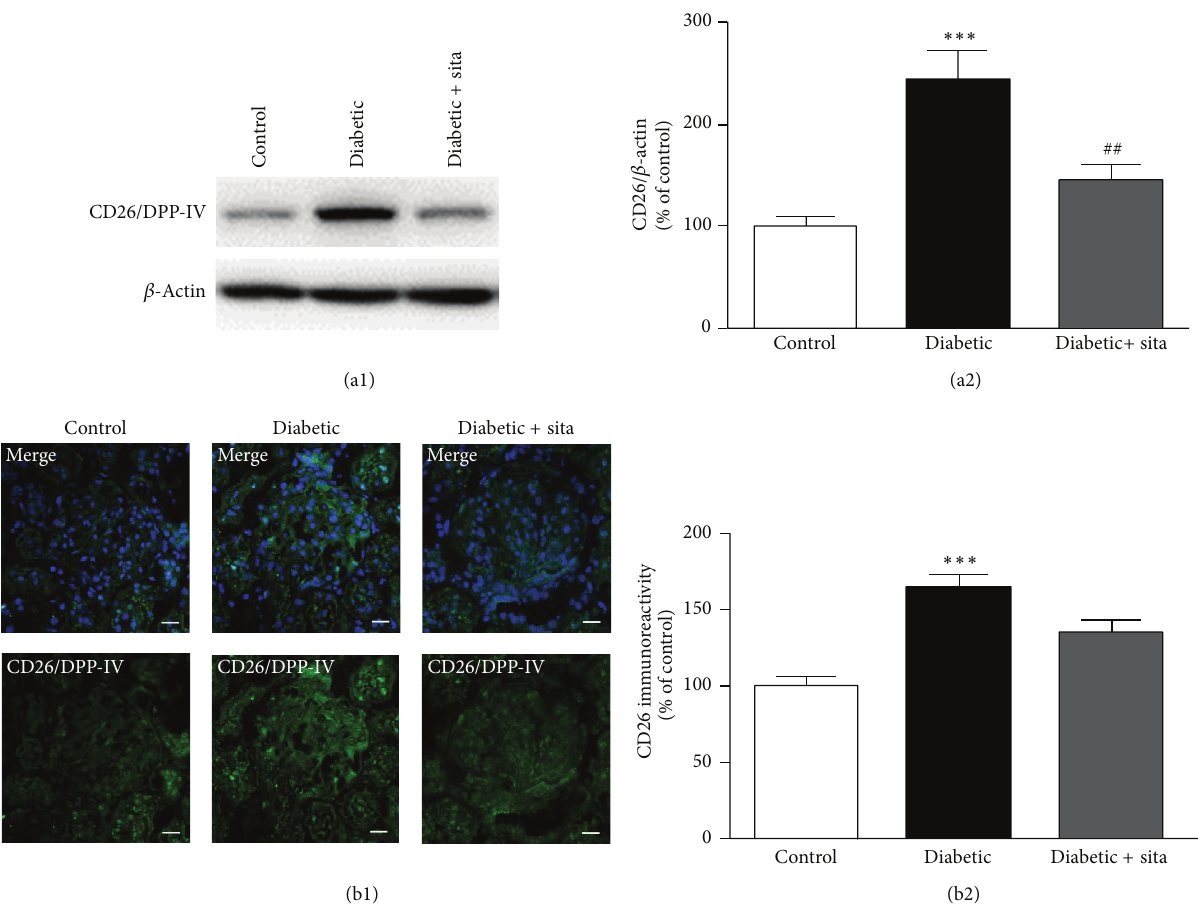
Figure 3: Sitagliptin prevents the upregulation of DPP-IV content in the kidney induced by diabetes. (a) The protein levels of DPP-IV were assessed in total kidney cell lysates by Western Blotting in ZDF (+/+) and ZDF ( fa/fa ) nontreated or treated with sitagliptin. The Western Blots presented are representative of each group of animals. (b) Representative confocal images for each group of animals showing DPP-IV (green) immunoreactivity and nuclear staining with DAPI (blue) in kidney sections (b1), as well as immunoreactivity quantification for DPP-IV (a2). Bars = 20 𝜇 m. Data are expressed as percentage of control and represent the mean ± SEM ( 𝑛 ≥ 6 per group); ∗∗∗ 𝑃 < 0.001 significantly different from control; ## 𝑃 < 0.01 significantly different from